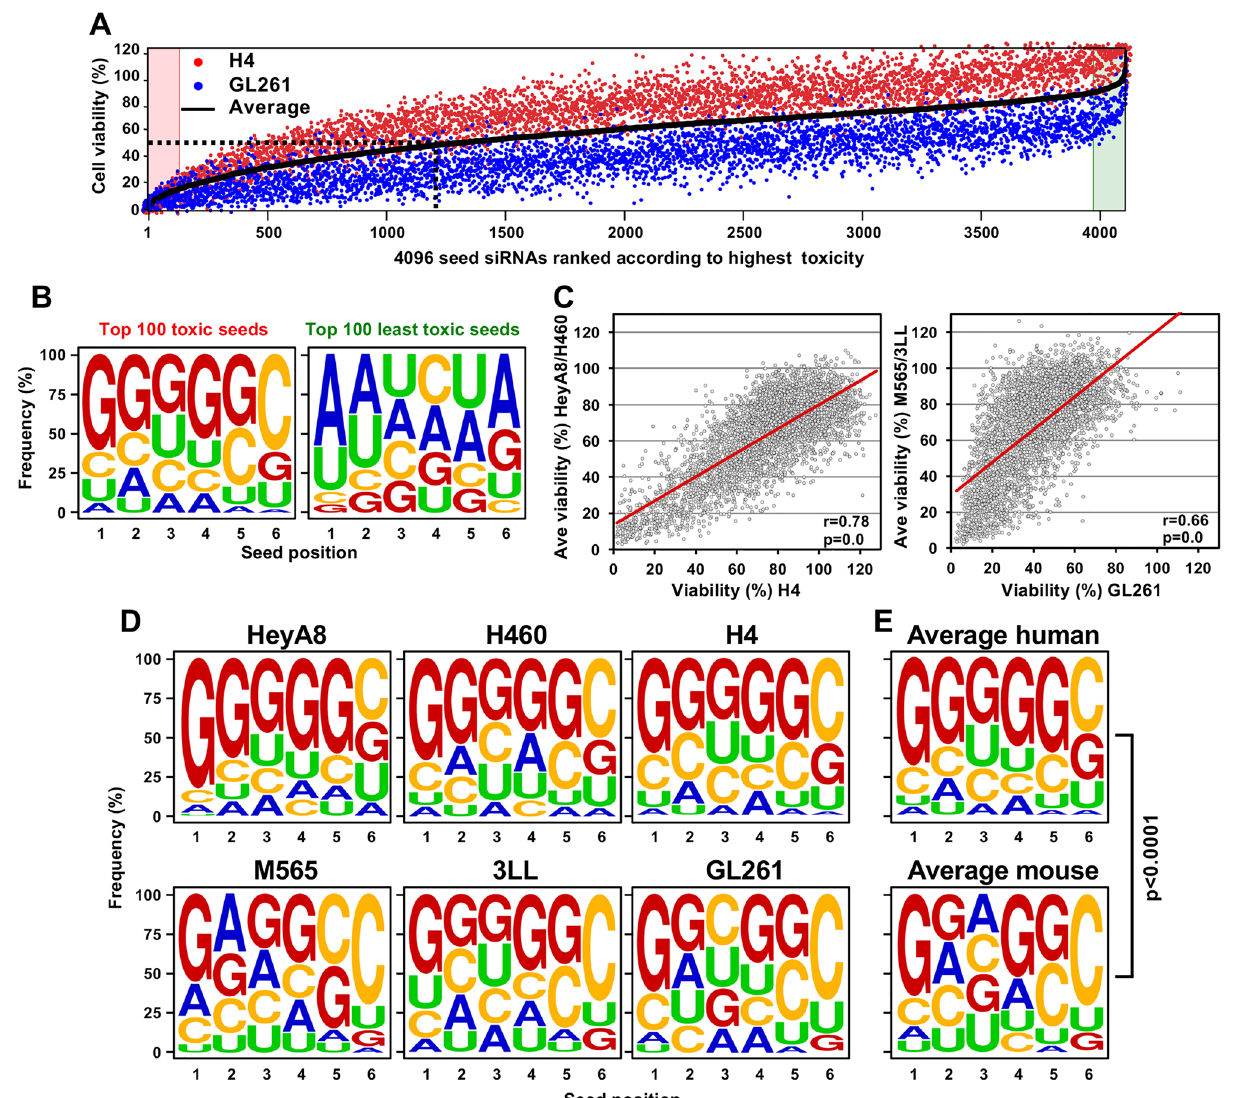
Figure 1. Subtle difference in the composition of the most toxic 6mer seed between human and mouse cancer cell lines. ( A ) Results of the 4096 6mer seed duplex screen in a human (H4) and a mouse (GL261) glioma cell line. Cells were reverse transfected in triplicates in 384 well plates with 10 nM of individual siRNAs. The cell viability of each 6mer seed duplex was determined by quantifying cellular ATP content 96 h after transfection. All 4096 6mer seeds are ranked by the average effect on cell viability of the two cell lines from the most toxic (left) to the least toxic (right). We consider an siRNA highly toxic if it reduces cell viability 90% or more and moderately toxic if it reduces cell viability 50% or more (black stippled line). ( B ) Average seed composition of the 100 most (left) and 100 least (right) toxic 6mer seeds in H4 and GL261 cells screened with 4096 6mer seed containing siRNAs. ( C ) Left: Regression analysis showing correlation between the 6mer Seed Tox observed in H4 cells and the average of the two previously tested human cell lines HeyA8 and H460. Right: Regression analysis showing correlation between the 6mer Seed Tox observed in GL261 cells and the average of the two previously tested murine cell lines 3LL and M565. p-values were calculated using Pearson correlation analysis. ( D ) Seed composition of the 100 most toxic 6mer seeds in three human (top) and three murine (bottom) cell lines. ( E ) Average most toxic seed composition of all human (top) and all murine (bottom) cell lines. p-value is derived from a multinomial mixed effects regression